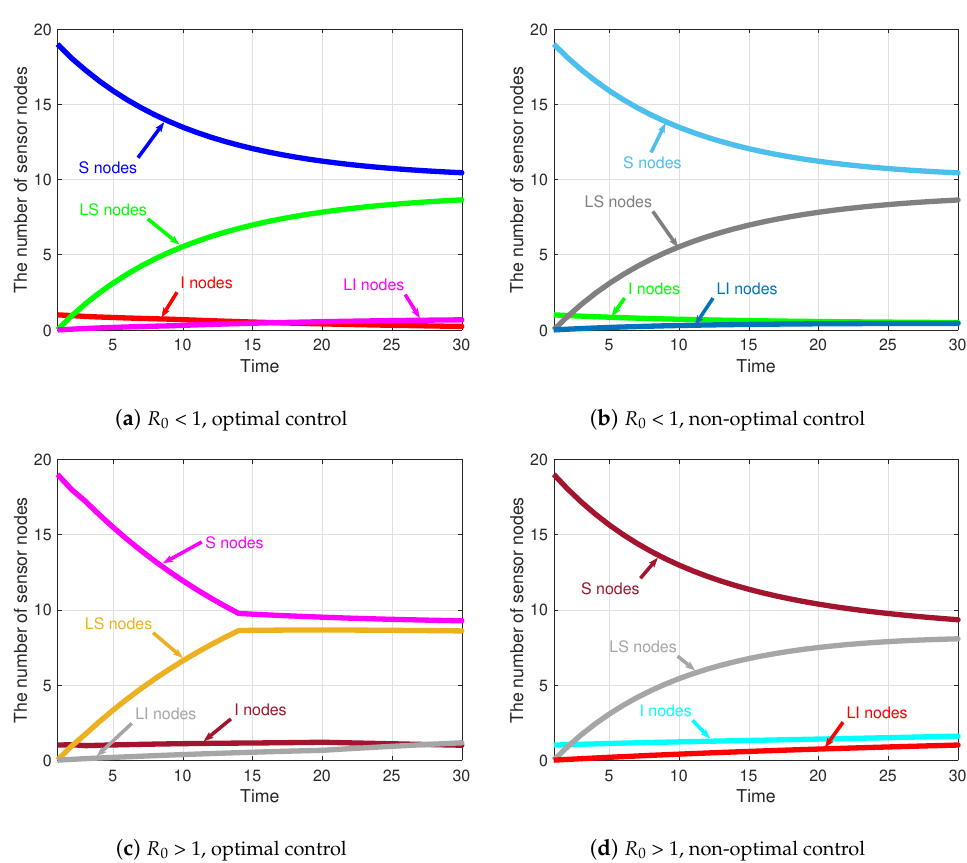
Figure 7. Evolution of sensor nodes under four different